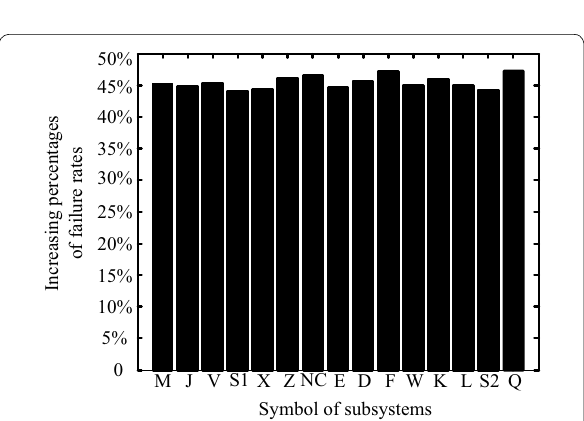
Figure 5 Increasing percentages of failure